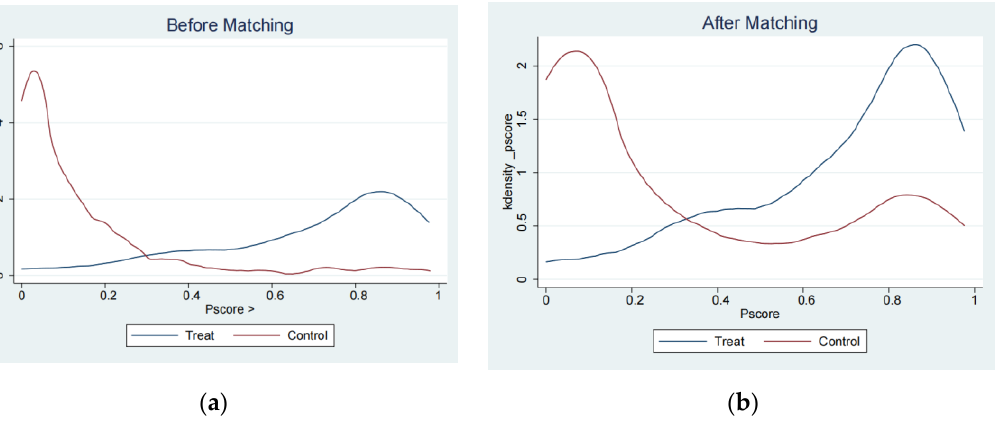
Figure 4. The density function of variables’ propensity scores of the land in-transfers group and the control group: ( a ) The density function graph of variables’ propensity scores before matching; ( b ) The density function graph of variables’ propensity scores after matching.